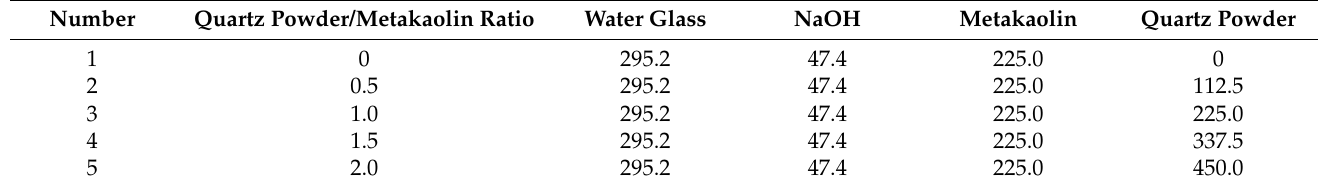
Table 3. Composition of HMGC with different quartz powder contents (unit: g).